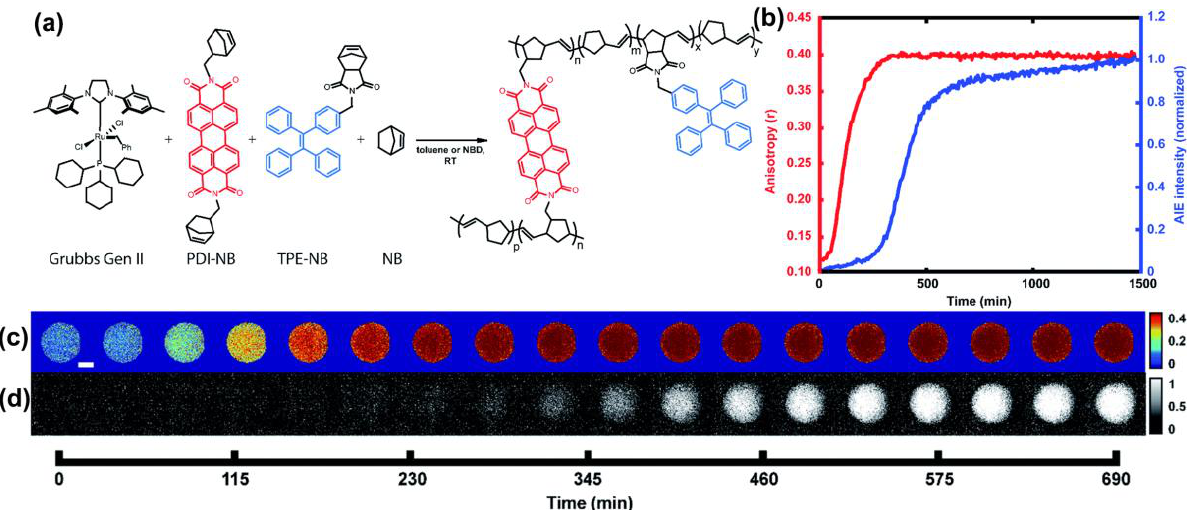
Figure 5. ( a ) Illustration of the ROMP reaction process. ( b ) The relationship of average anisotropy and AIE intensity with time. ( c ) The photographs of anisotropy values in droplets over time. ( d ) Emission intensity of the AIE monomer probe in a droplet over time. Reprinted with permission from open access of Ref. [43]. 2020, Royal Society of Chemistry.